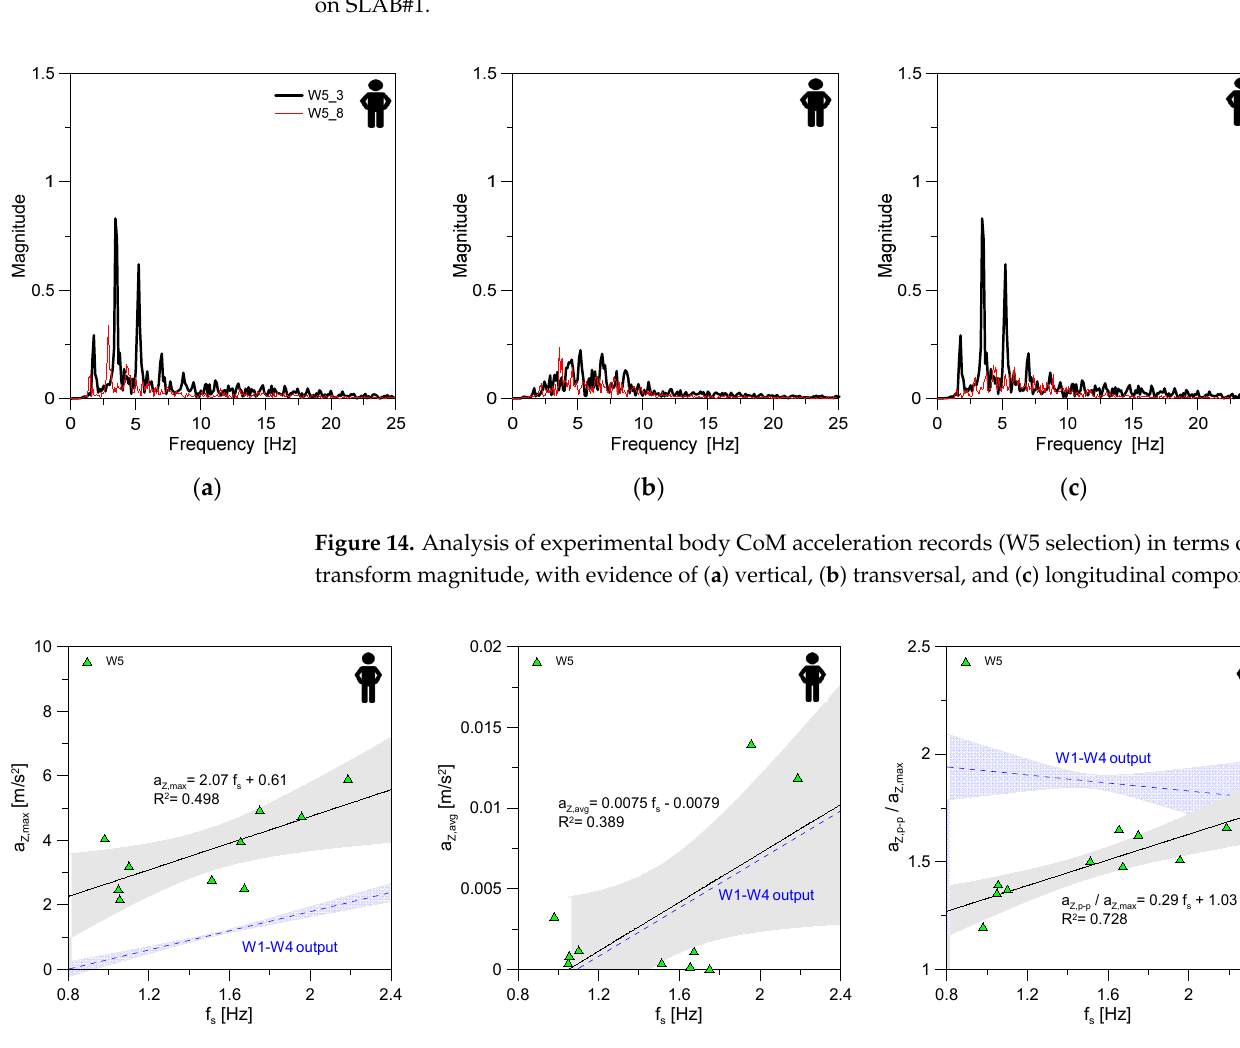
Figure 14. Analysis of experimental body CoM acceleration records (W5 selection) in terms of fast transform magnitude, with evidence of ( a ) vertical, ( b ) transversal, and ( c ) longitudinal components. 0.8